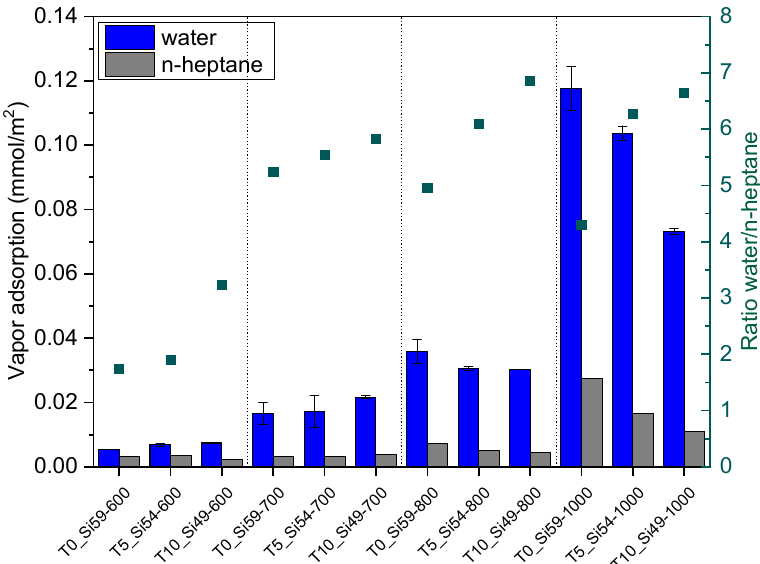
Figure 6. Water and n-heptane vapor adsorption, and the ratio of the maximum water and n-heptane adsorption (right axis) for all of the samples pyrolyzed at different temperatures (600–1000 °C).